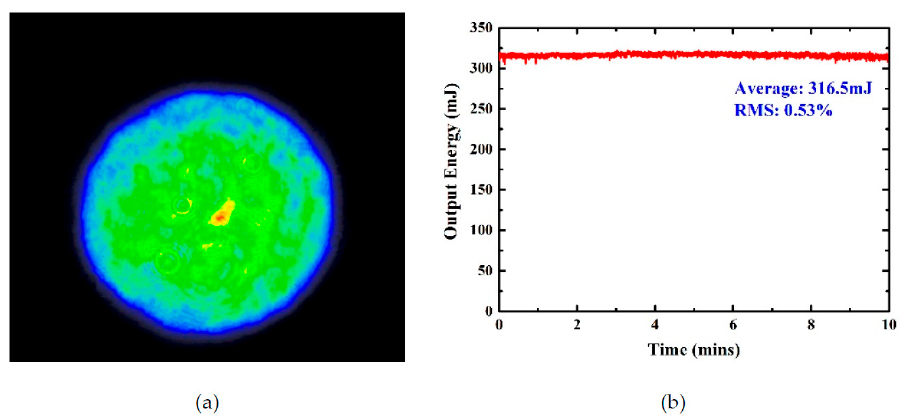
Figure 4. ( a ) Beam distribution and ( b ) energy stability of amplified pulses from the whole amplifier.